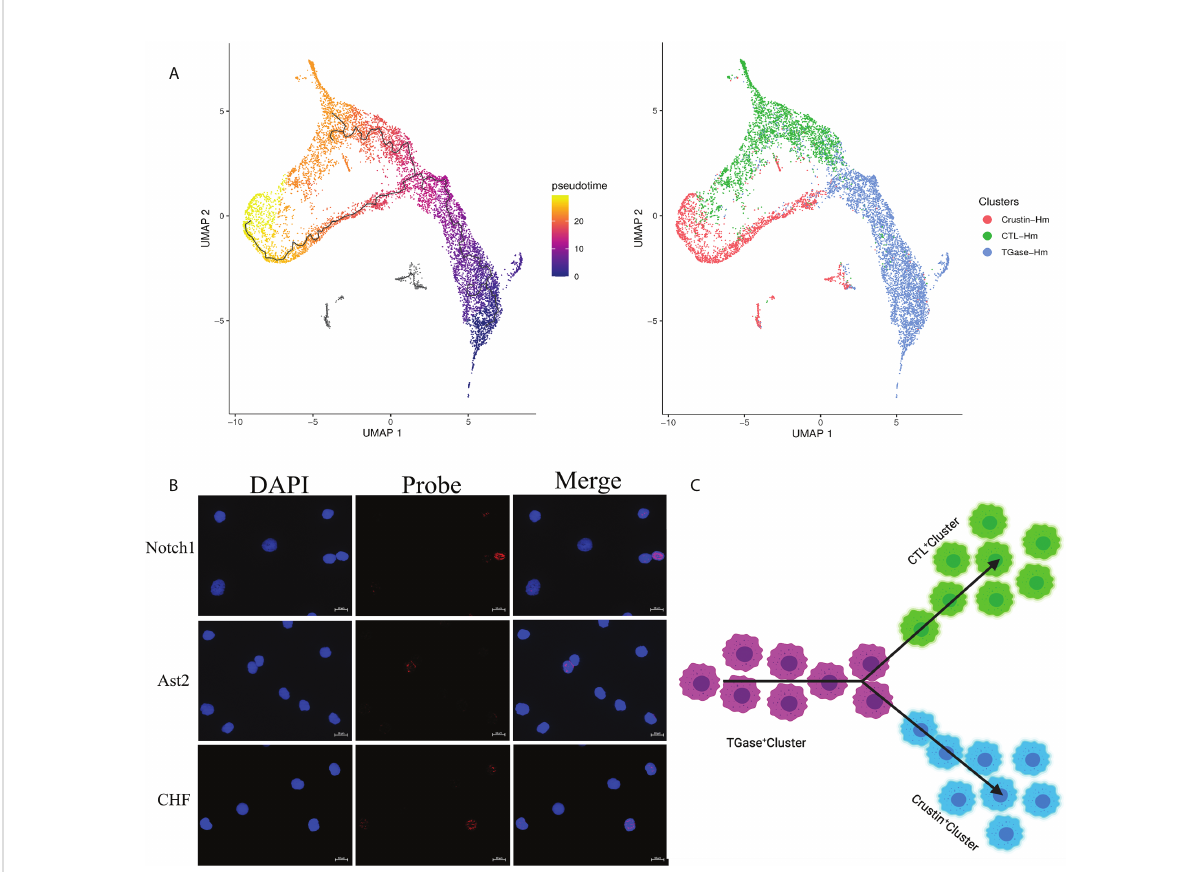
FIGURE 4 Pseudotemporal ordering of cells delineates hemocytes lineages. (A) Monocle 3 was used to track hemocytes over pseudotime on the 10X data sets. Visualization of cell clusters (from Figure 1C) onto the pseudotime map. (B) Validation of the key differentiation genes (Notch1, Ast2